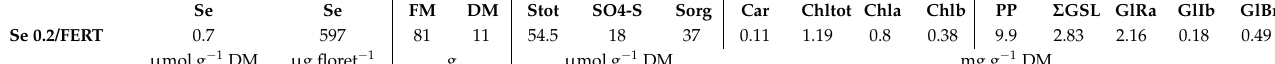
Table 5. Overview of the performance of the application mode per treatment for the applied Se 0.2 mM concentration enriched with cysteine, methionine, cysteine plus methionine, or the mix of phenylalanine, tryptophane, and methionine, in terms of percentage difference with the control plants (Se0.2/FERT). The percentage of changes was evaluated against the selenium content of florets either as µ mol g − 1 DM or µ g floret − 1